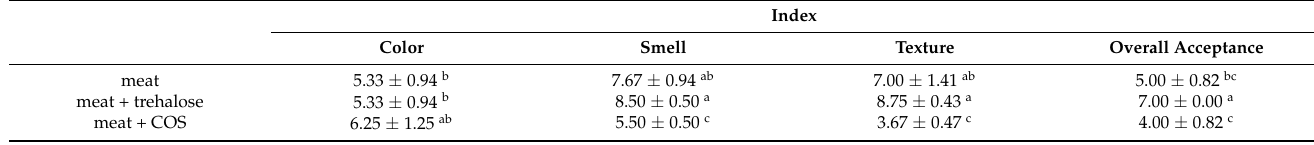
Table 4. Sensory evaluation of